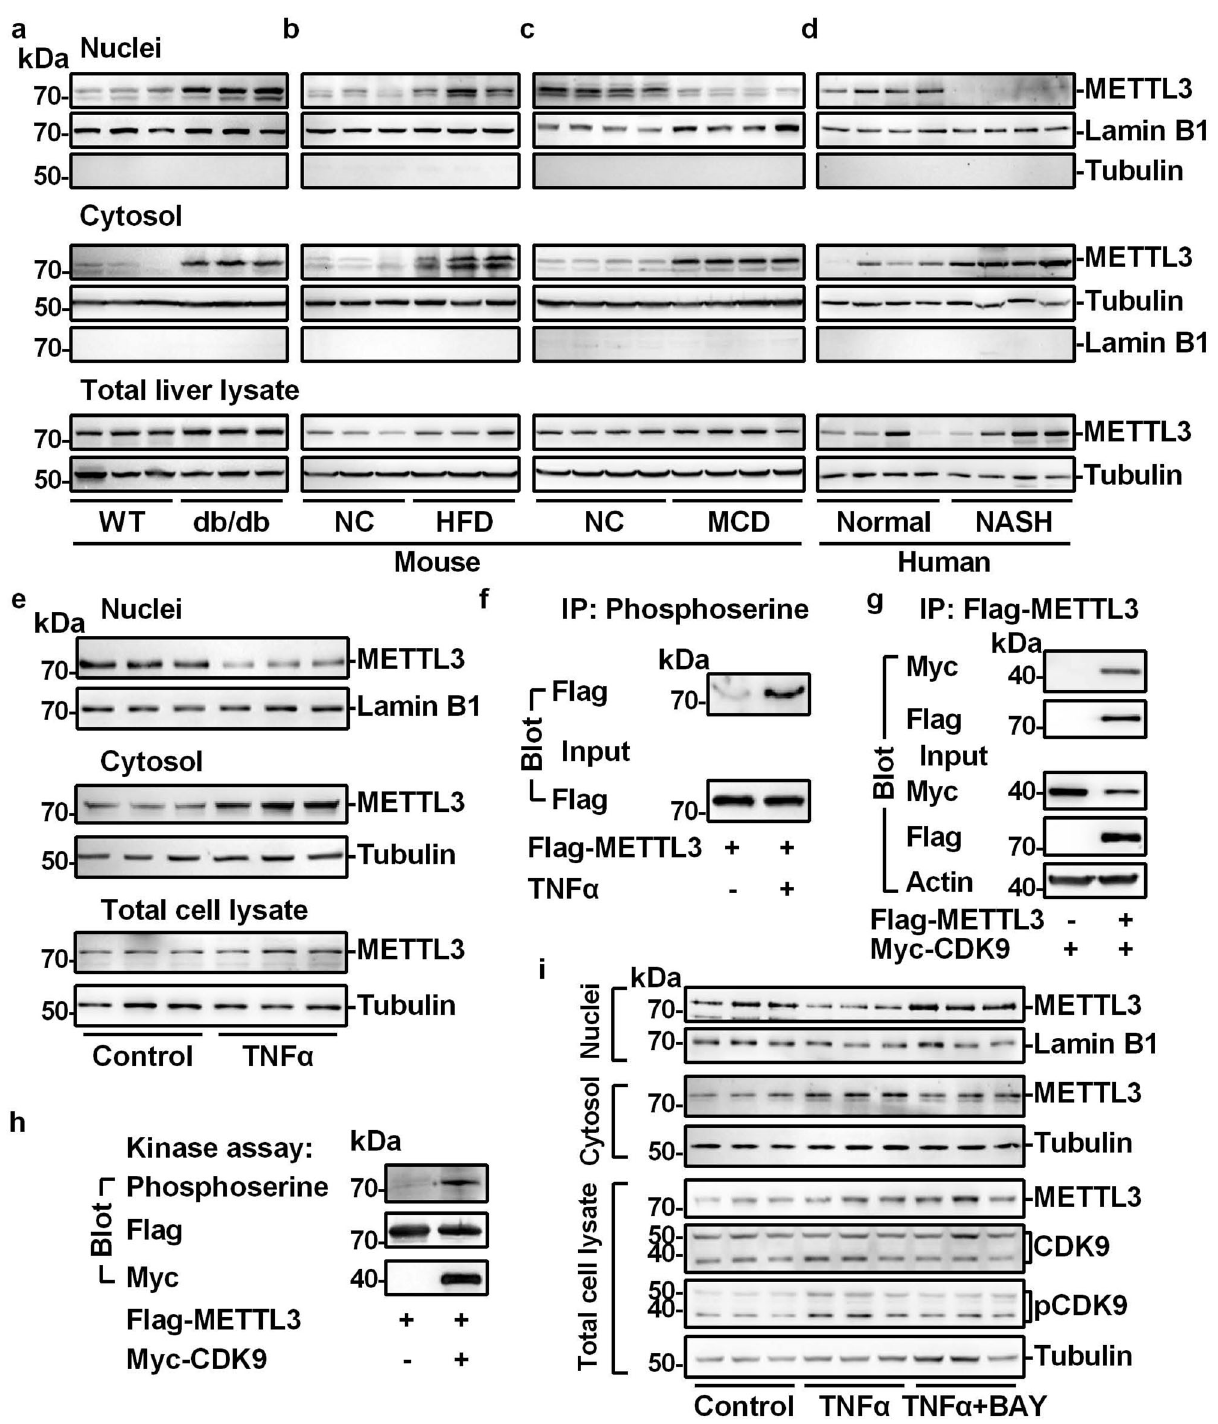
NAFL-to-NASH transition, we generated hepatocyte-speci fi c Mettl3 knockout (HKO) mice by crossing Mettl3 fl ox/ fl ox mice with Alb - Cre transgenic mice. The genotype of the Mettl3 -HKO mice was Mettl3 fl ox/ fl ox Alb - Cre + / − . As expected, METTL3 protein levels were dramatically decreased by 93.2% in the livers of Mettl3 -HKO mice (Fig. 2a). We did not observe any differences in body weights (Supplementary Fig. 2a), serum triacylglycerol (TAG) levels (Sup- plementary Fig. 2b), liver weights (Supplementary Fig. 2c), or liver TAG levels (Supplementary Fig. 2d) between Mettl3 fl ox/ fl ox and Alb - Cre mice. Mettl3 fl ox/ fl ox mice also displayed similar